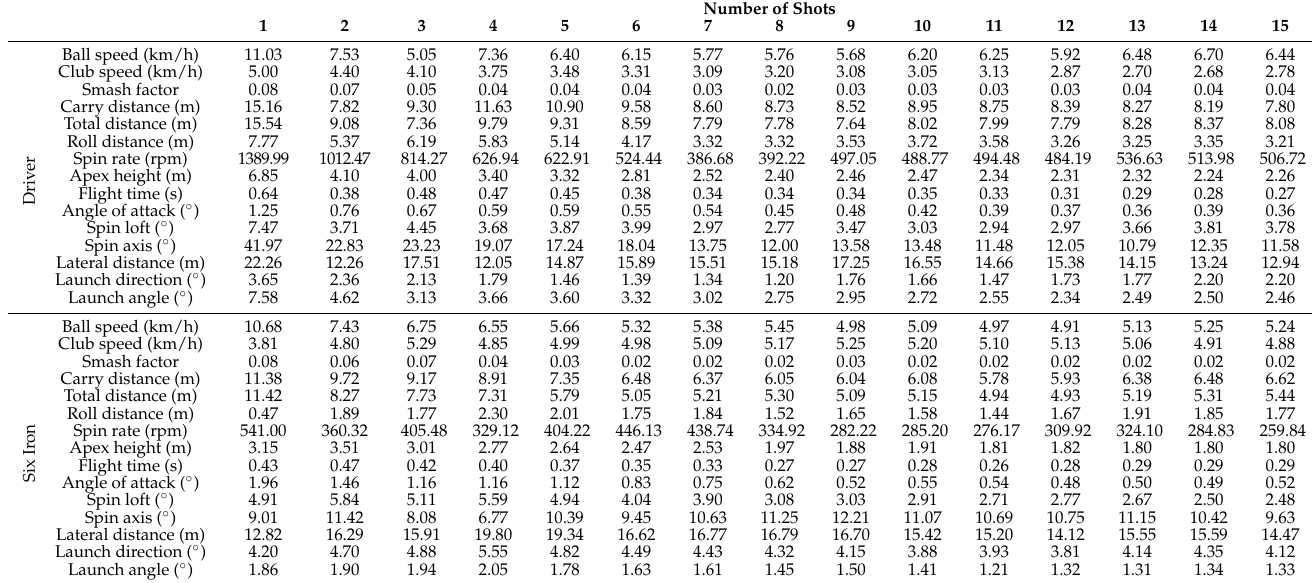
Table 1. Standard error of the measurement for FlightScope Mevo+ extracted parameters.